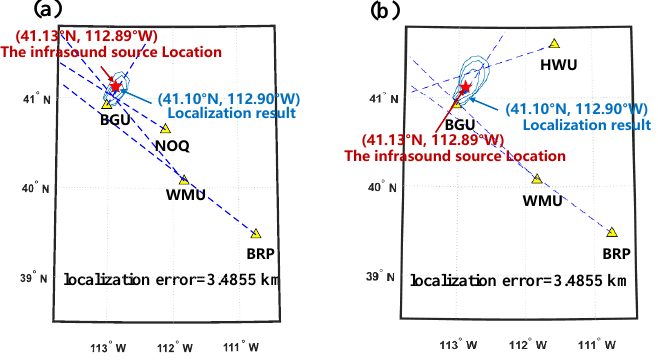
Figure 16. The influence of the spatial distribution of infrasound stations on the localization results (arrival azimuth estimation results from the SBL algorithm); ( a ) BGU, NOQ, WMU, and BRP; ( b ) BGU, HWU, WMU, and